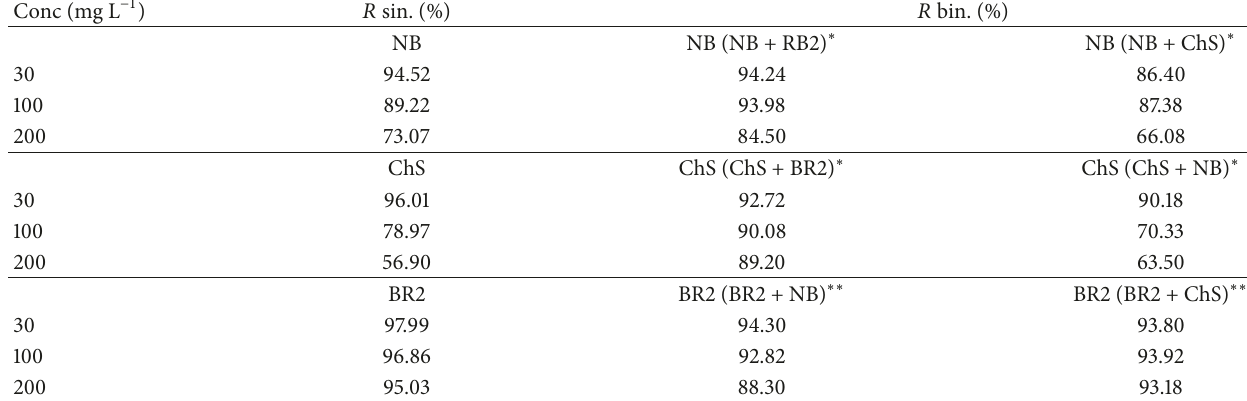
Table 9: Effect of initial concentration on dyes removal efficiency for binary